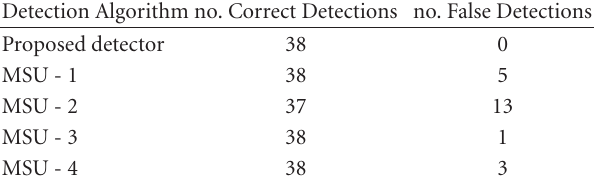
Table 2: Performance comparison of the proposed detector and four di ff erent detection algorithms implemented by the MSU software tool, for a 12.5 fps CIF sequence with no losses.